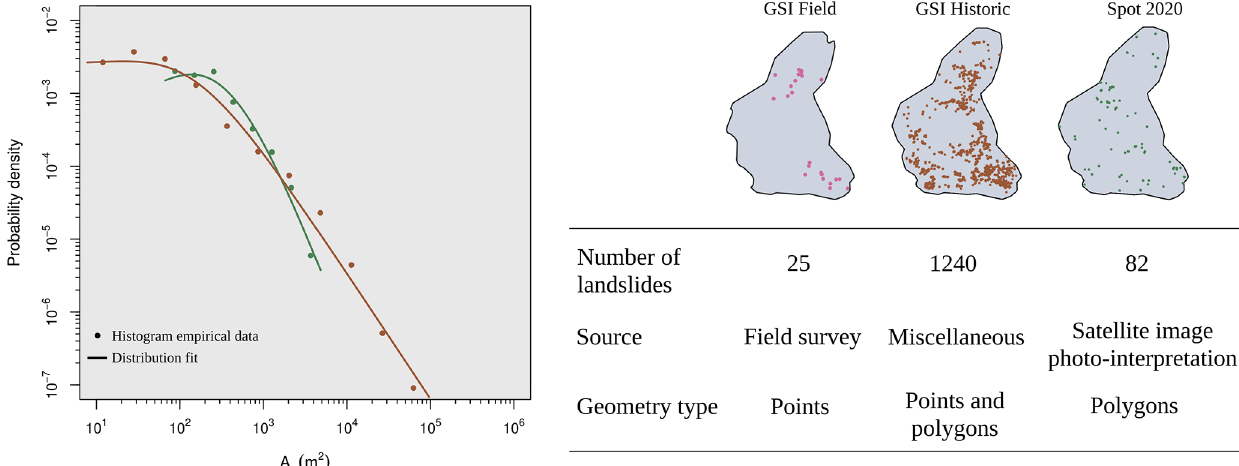
Figure 3. Frequency area distribution curves (FAD curves) for Spot 2020 (green) and GSI Historic (brown). Landslide distribution map for Spot 2020, GSI Historic and GSI Field. Summary table of the inventories.